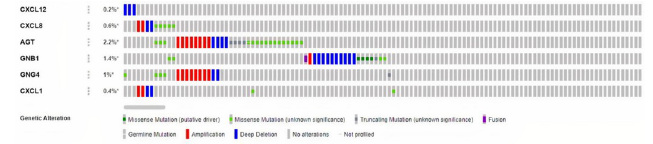
Fig 12. Frequency of the genetic alterations and CNVs of the real hub genes in COAD